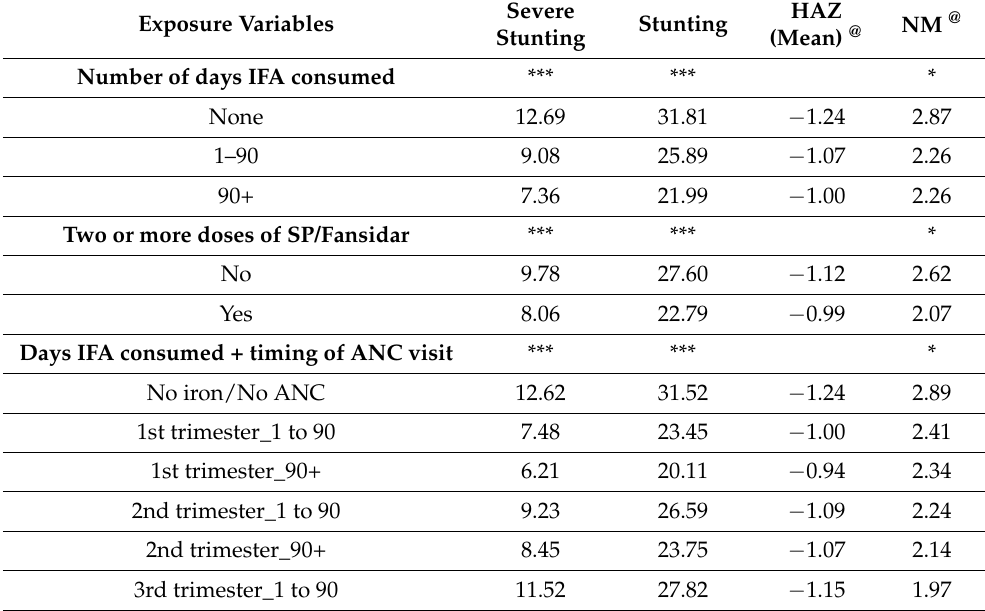
Table 3. Distribution of the exposure variables by